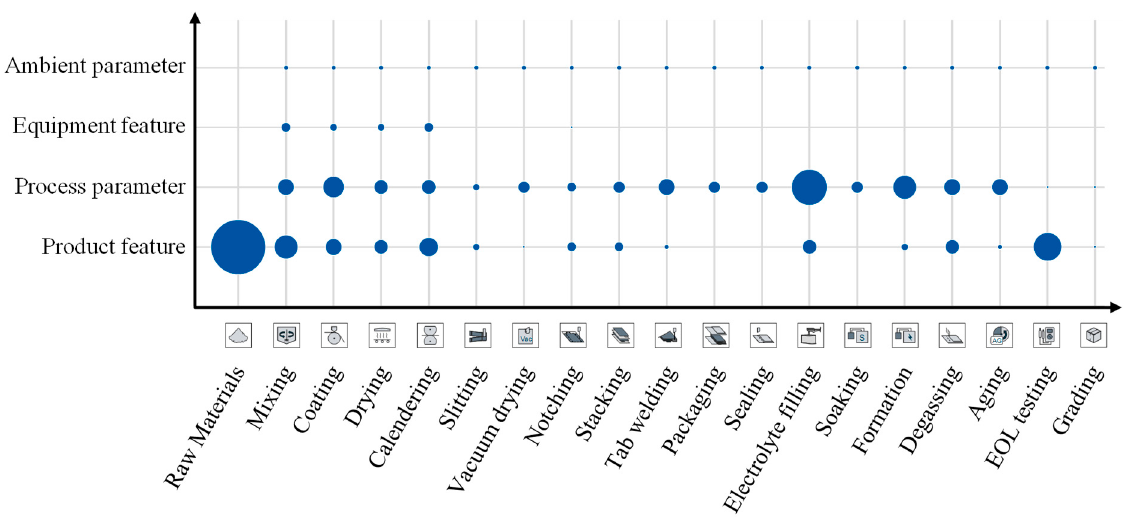
Figure 6. Distribution of the di ff erent parameter categories along the ba tt ery cell production chain.